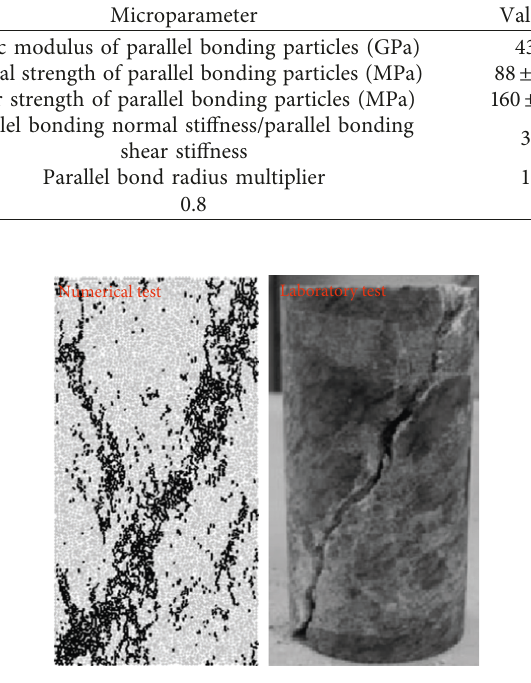
Figure 2: Comparison of failure modes obtained by experiment and simulation under triaxial